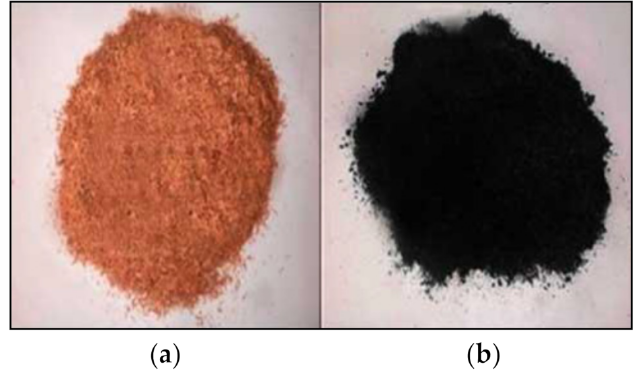
Figure 25. ( a ) Rice husk and ( b ) biochar from rice husk [107].